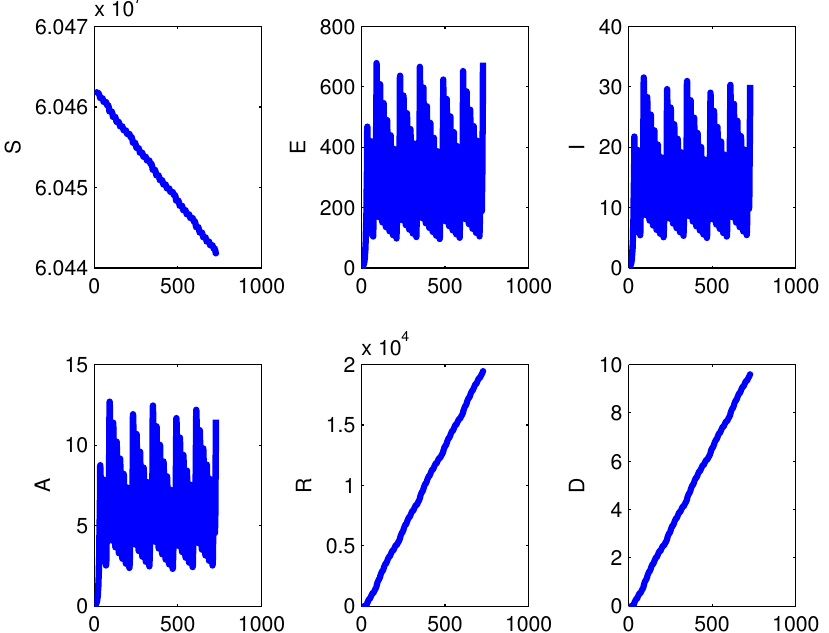
Figure 19. The population values with the lock-down policy, implemented after the first week with the reduced contact rate β I = 10 − 10 , after which β I = 10 − 7 resumes. The check for possible repeated implementation is implemented every week afterwards. The simulation runs over a two year timespan for the model (1) with no demographics, i.e., Λ = d p = 0. Left to right and top to bottom, the subpopulations are: S , E , I , A , R and D , the disease-related deceased class.